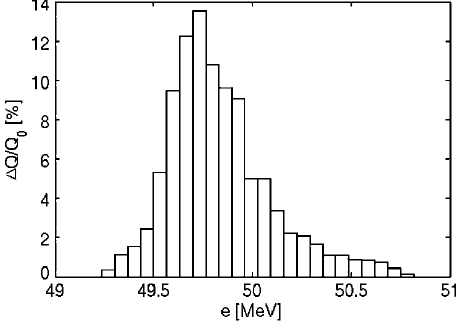
FIG. 14. CSRTRACK output energy